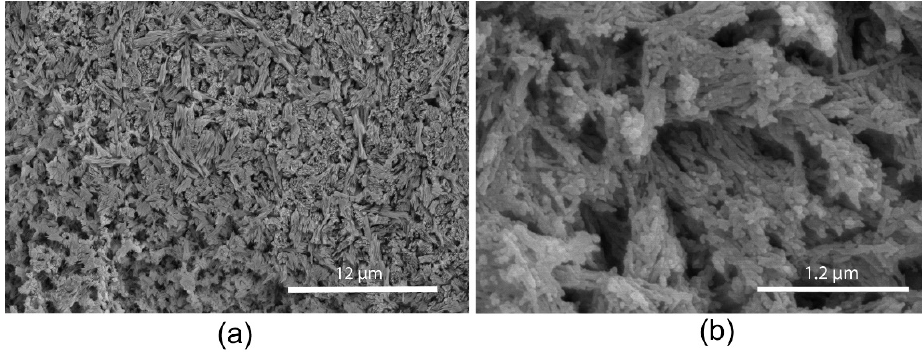
Figure 3. The ASIOP structure in the inner layer of Spiraserpula caribensis. ( a ) Longitudinal section, general view; ( b ) longitudinal section, showing substructure composed of elongated rods.